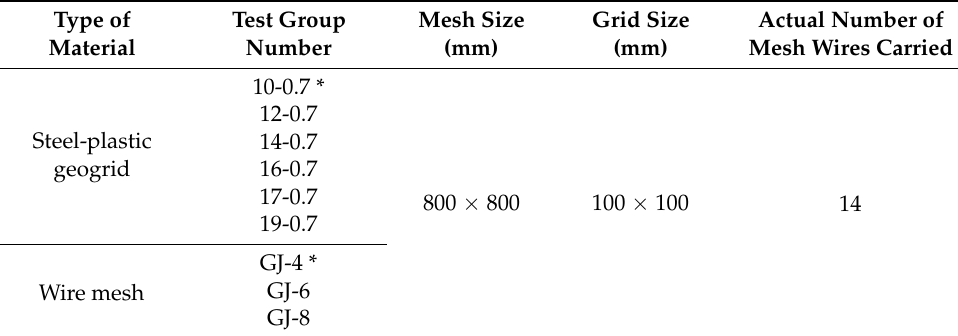
Figure 9. Net performance testing testbed. Table 3. Design of test sets for mesh load-bearing capacity